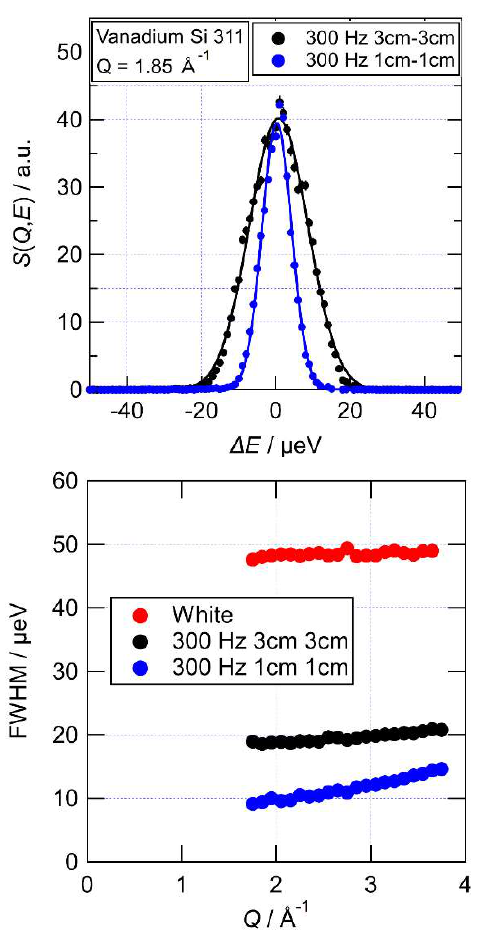
Fig. 3. The energy resolutions of Si311 analyzer mirrors under the conventional condition of the sample size of 1.4 cm (D) × 4 cm (H) with the slit size of 3 cm × 3 cm and 1 cm × 1 cm (Top). The Q -dependences of the energy resolutions for the Si311 analyzer is shown in the bottom. “White” (red) corresponds to the condition without operating